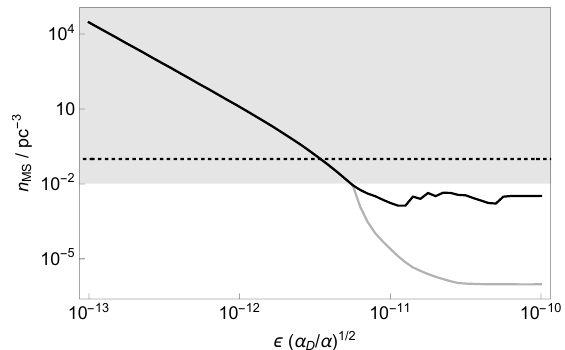
Figure 8. Constraints on mirror star number density as a function of the kinetic mixing parameter and dark QED coupling, assuming SM-like mirror stars with a SM-like mass function. For (cid:15) (cid:28) 10 − 11 , the dominant constraint comes from requiring the expected number of observed optically thin mirror stars to be less than 4. For (cid:15) & 10 − 11 , the limit is dominated by optically thick mirror stars, with the black (gray) curve corresponding to using current (optimistic future) limits on their observed number. In the gray shaded region, the mirror star mass density excluded by Gaia exceeds the local dark matter density. The black dotted line is the local number density of regular stars.